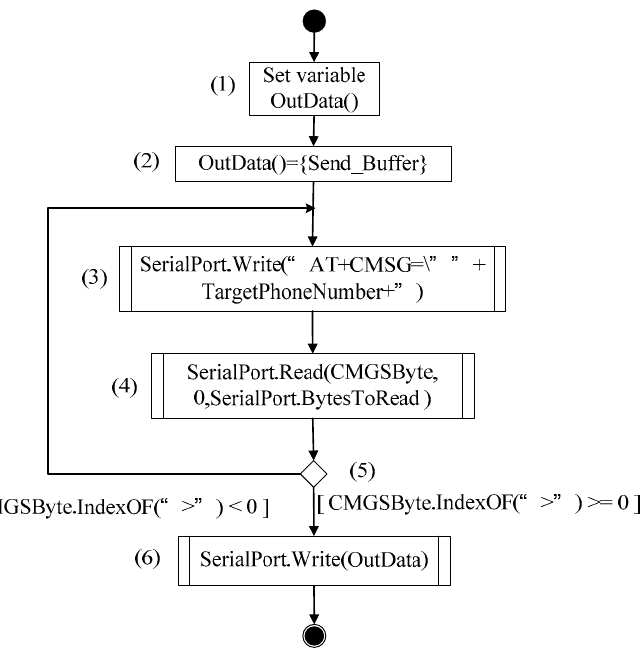
Figure 6. The ‘send’ process in GSM/SMS communication.